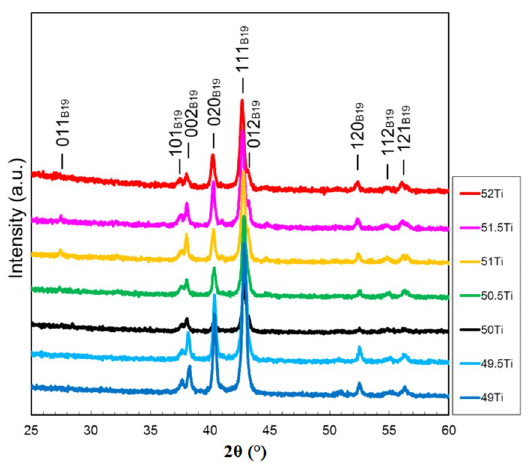
Figure 1. X-ray diffraction (XRD) profiles of the (49–52)Ti alloys solution treated at 1173 K.